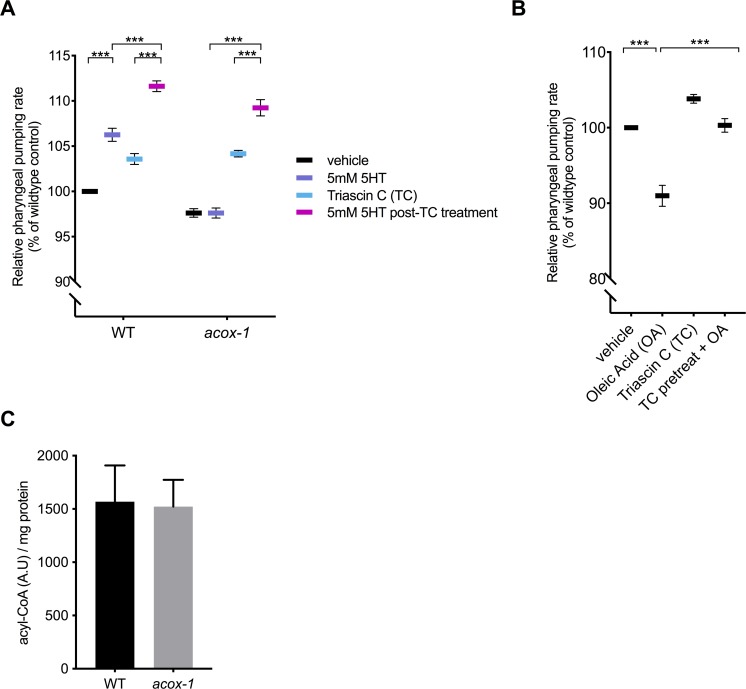
Modulation of feeding by ACOX-1 requires fatty acyl-CoA synthesis.(A) Inhibiting ACSs in acox-1(ok2257) animals restores the ability to elevate feeding in response to 5 mM serotonin. Day 1 adult animals were pretreated with vehicle or 1 μM ACS inhibitor Triacsin C for 90 minutes before being plated on vehicle or 5 mM 5HT plates. Feeding rates were assessed after 60 minutes on assay plates. Feeding data are normalized to vehicle-treated wild-type animals and are presented as a percentage of wild-type rates. Error bars indicate ±SEM from normalized mean, n = 15 animals per condition. ***p < 0.001 ANOVA (Tukey). (B) Animals were treated with 1 mM oleic acid (OA) or 1 μM Triacsin C (TC) for one hour, or pretreated with 1 μM TC for one hour prior to OA treatment before feeding was assayed. Error bars indicate ±SEM from normalized mean, n > 15 per strain. ***p < 0.001, ANOVA (Tukey). See S1 Table and S1 Data for underlying data. At the concentration used (0.0002%), DMSO had no effect on pumping rate. (C) Acyl-CoA levels in acox-1 mutants are unchanged relative to WT. Acyl-CoA species were separated and quantified by HPLC and normalized to protein concentrations, n = 3 independent extractions. ACOX-1, acyl-coenzyme A oxidase 1; ACS, acyl-coenzyme A synthetase; CoA, co-enzyme A; HPLC, high-pressure liquid chromatography; WT, wild-type; 5HT, 5-hydroxytryptamine.